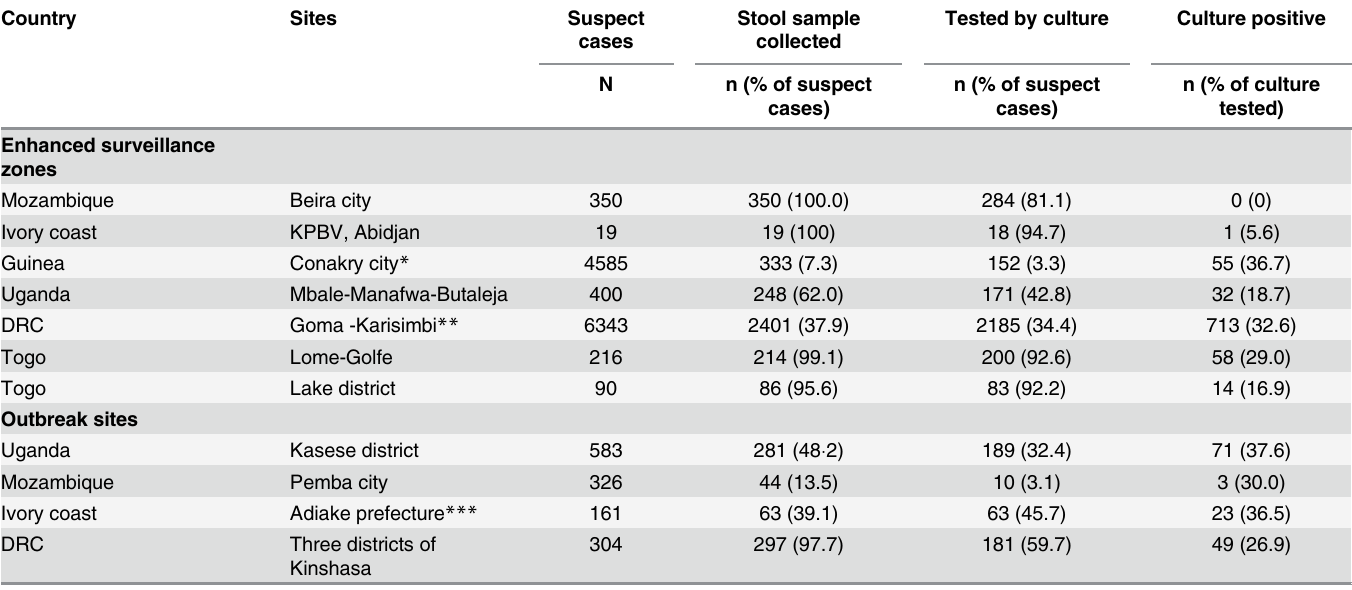
Table 1. Suspect cases with stool sample collected, culture test done and culture positive result. N =